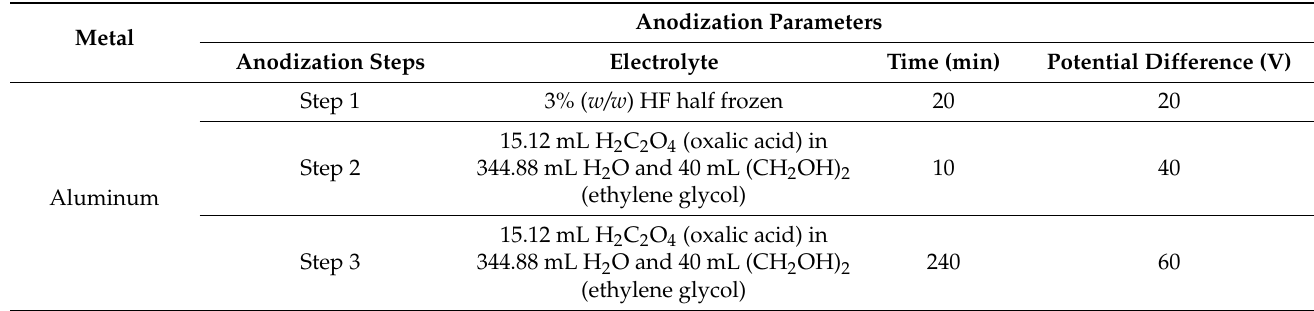
Table 2. Applied anodization parameters for aluminum adherends.